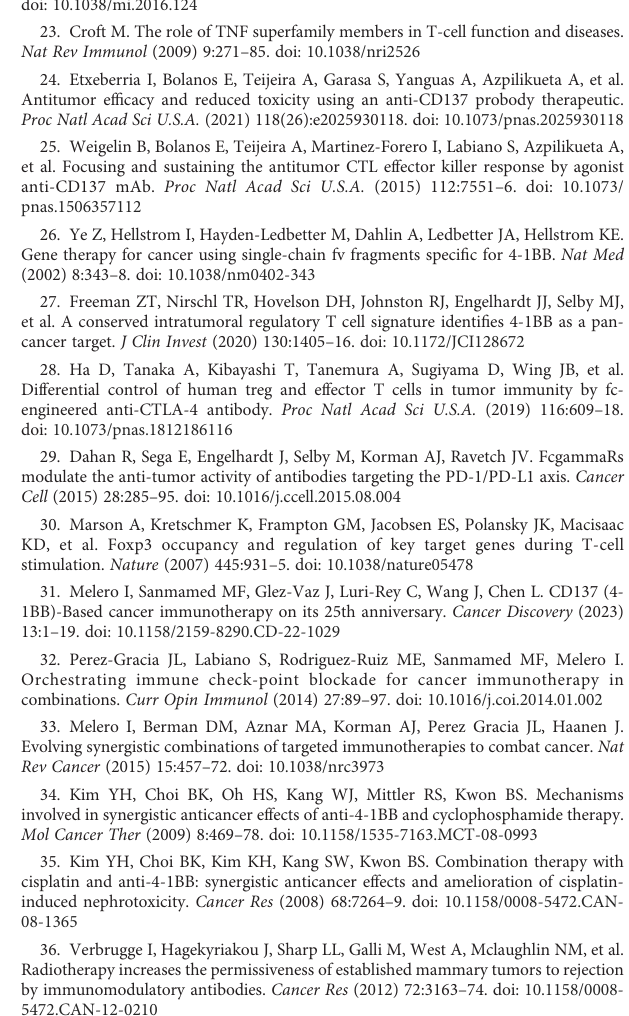
SUPPLEMENTARY FIGURE 3 PCSK9 was an independent risk factor for OS in advanced NSCLC patients with anti-PD1 immunotherapy. (A). Kaplan-Meier graph for overall survival in the population of PCSK9 hi and PCSK9 lo group. (B). Univariate and multivariate analyses of factors associated with overall survival. Data cutoff was April 30, 2022. *PD-L1 negative, TPS<1%; PD-L1 low, TPS<50%; PD-L1 high, TPS ≥